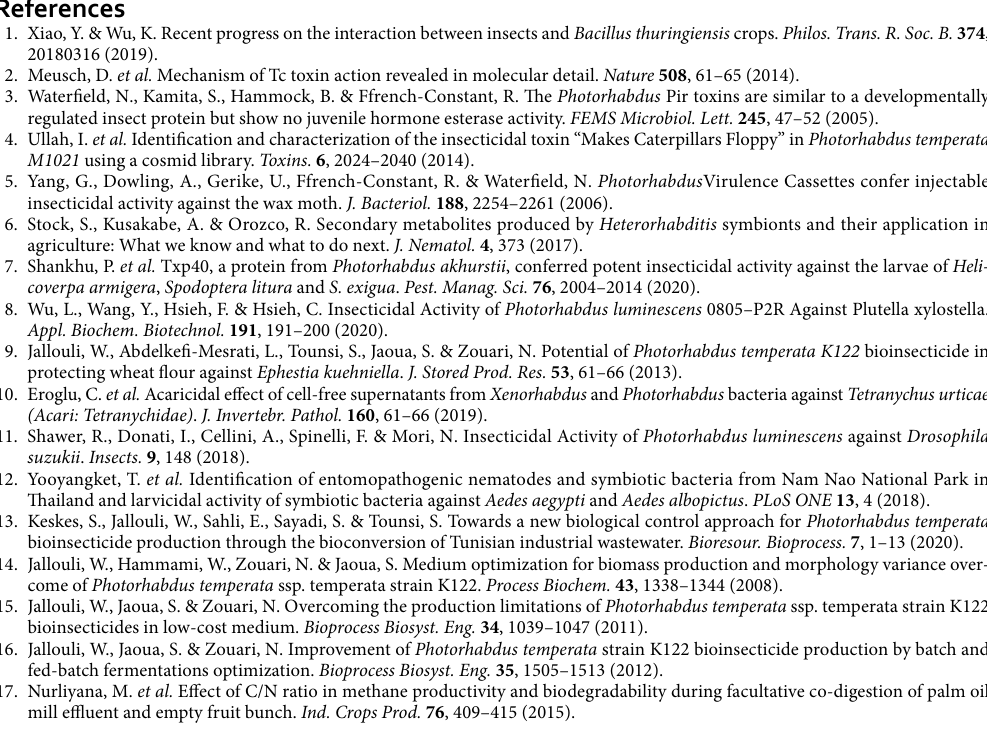
and 42% (p ˂ 0.0001) after the same incubation times (Fig. 7). Increase in P. temperata toxicity highlights that